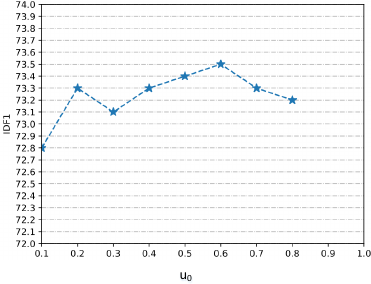
Figure 5. The change of IDF1 indicator as u 0 changes.